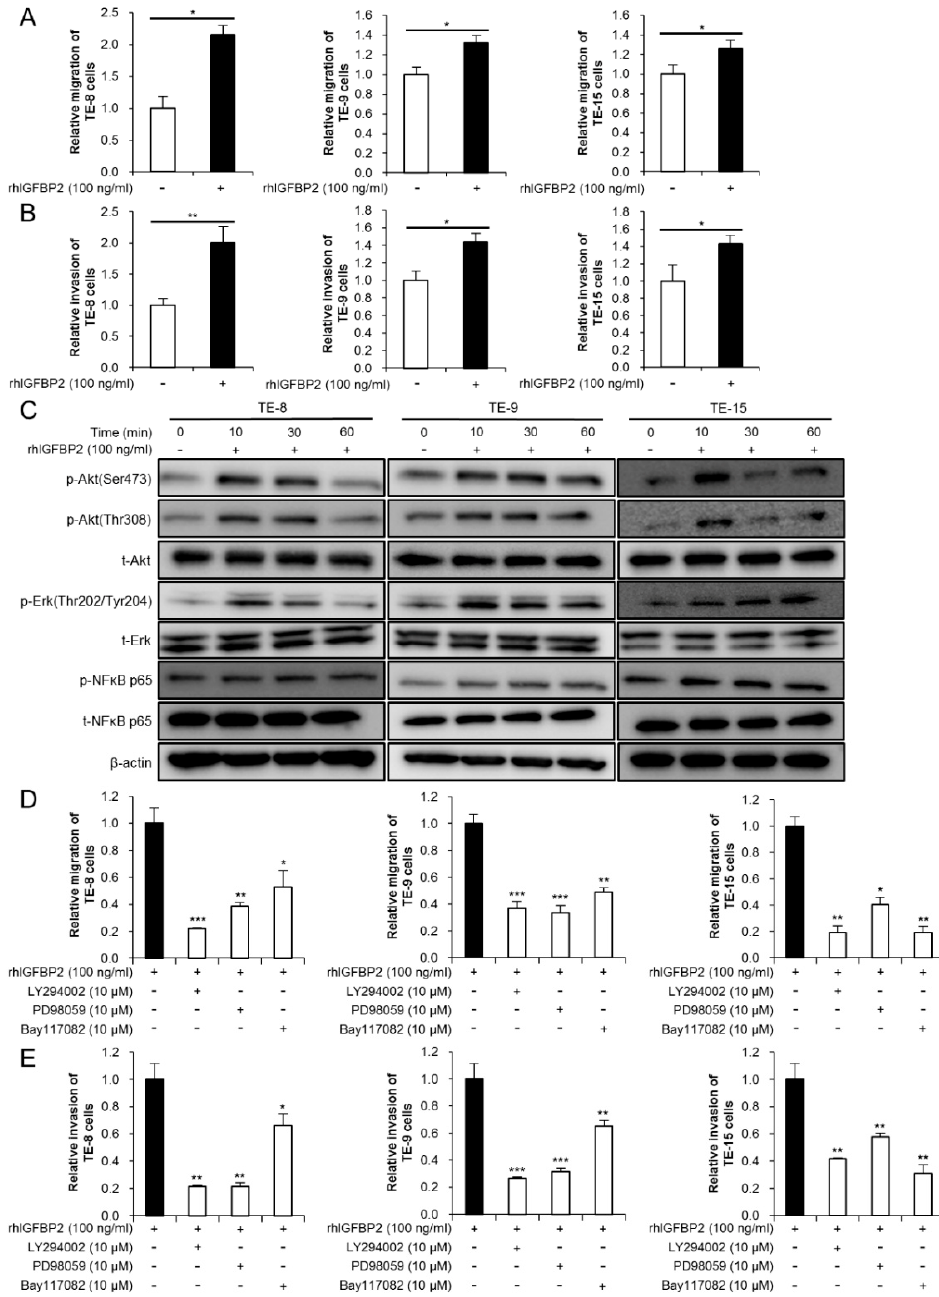
Figure 4. IGFBP2 promoted migration and invasion in ESCC cell lines through Akt, Erk, and NF κ B signaling pathways. ( A ) Transwell migration assay of three ESCC cell lines stimulated with recombinant human IGFBP2 (rhIGFBP2). RhIGFBP2 was added to the lower chamber at a concentration of 100 ng/mL. Migrating cells on the bottom of the upper chamber were counted in five randomly selected fields. ( B ) Transwell invasion assay of three ESCC cell lines stimulated with rhIGFBP2. RhIGFBP2 was added to the lower chamber at a concentration of 100 ng/mL. Invading cells on the bottom of the upper chamber were counted in five randomly selected fields. ( C ) Western blotting to confirm the changes in the levels of total and phosphorylated Akt, Erk, and NF κ B for 0, 10, 30, and 60 min after stimulation with rhIGFBP2 (100 ng/mL). TE-8, TE-9, and TE-15 cells were seeded on the day before protein extraction and incubated overnight in serum-free RPMI-1640. ( D , E ) Transwell migration ( D ) and invasion ( E ) assay of ESCC cell lines with inhibitors of phosphatidylinositol 3-kinase (PI3K inhibitor; LY294002, 10 µ M), MEK1/2 (PD98059, 10 µ M), and NF κ B (Bay117082, 10 µ M), stimulated with rhIGFBP2. Data are presented as mean ± SEM (* p < 0.05, ** p < 0.01, *** p < 0.001).